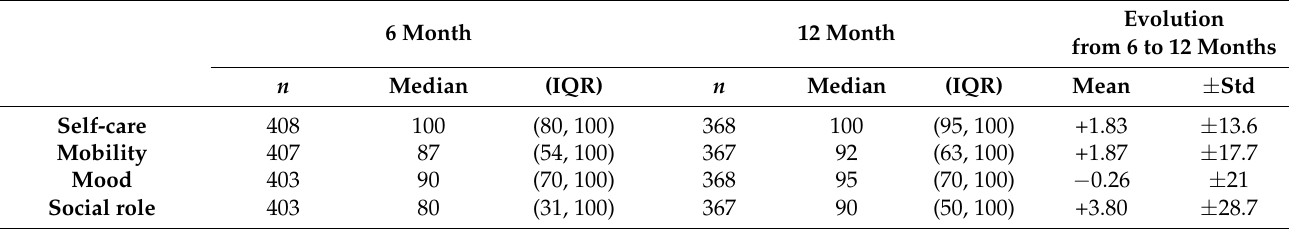
Table 2. SS-QoL quality of life scores at 6 and 12